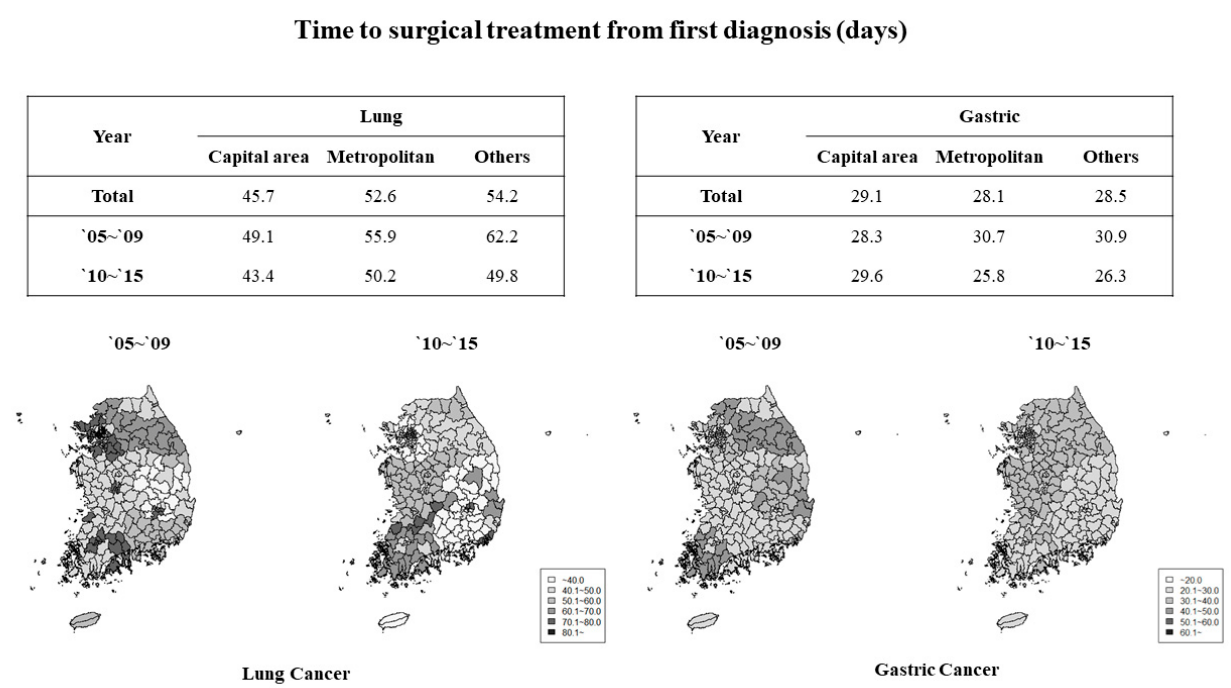
Figure 1. Average time-to-treatment of the study participants by region (days).